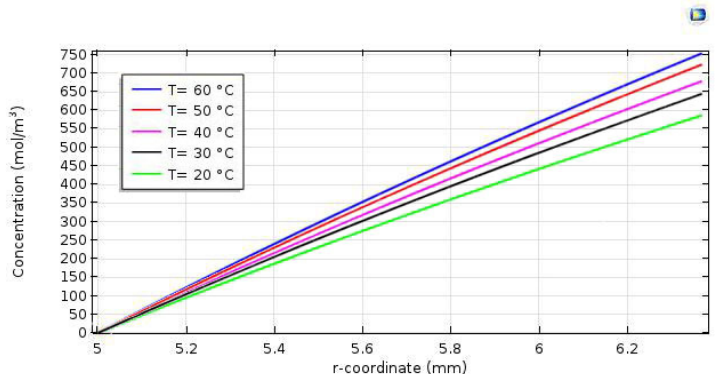
Fig. 12 Water concentration profile within the membrane vs. r-coordinate at different temperatures (3 l/min feed flow rate and 1 bar pressure)